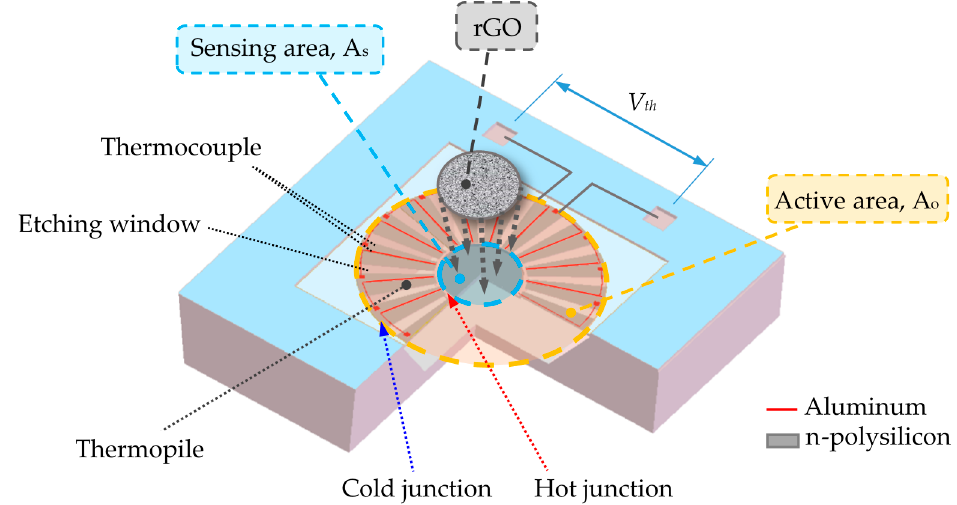
Figure 1. Schematic drawing of the complementary metal-oxide-semiconductor (CMOS)-MEMS thermopile.